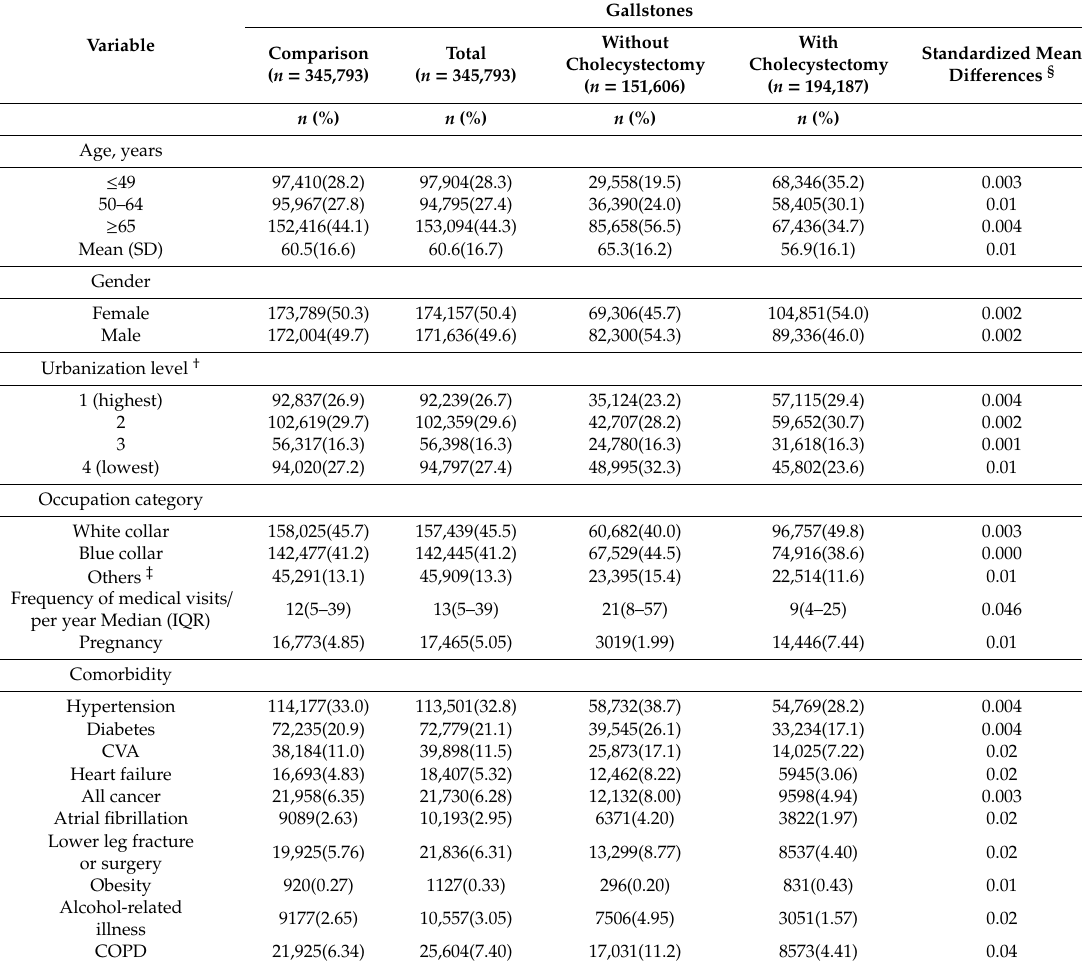
Standardized Mean Di ff erences